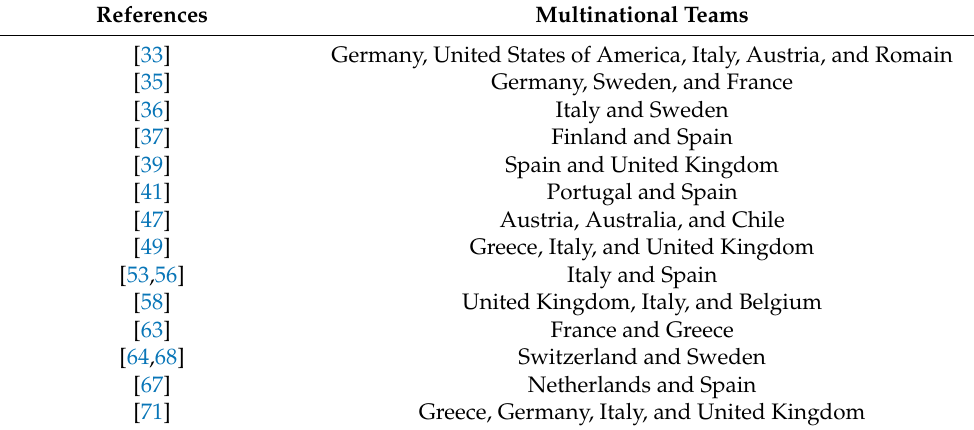
Table 1. Multinational